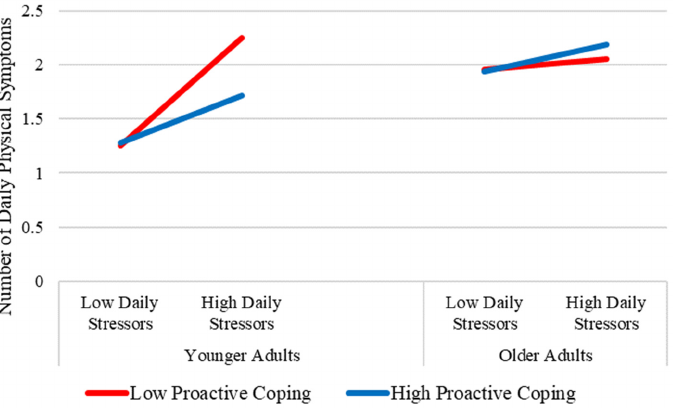
Figure 1. Significant 3-way interaction of daily stressors, age, and proactive coping predicting the number of daily physical symptoms (higher scores reflect more physical symptoms, worse health). Predicted points were plotted based on separate models for younger and older adults with low ( M − 1 SD ) and high ( M + 1 SD ) proactive coping and low ( M − 1 SD ) and high ( M + 1 SD ) daily stressors, adjusted for all covariates. Younger adults low in proactive coping were the most physically reactive